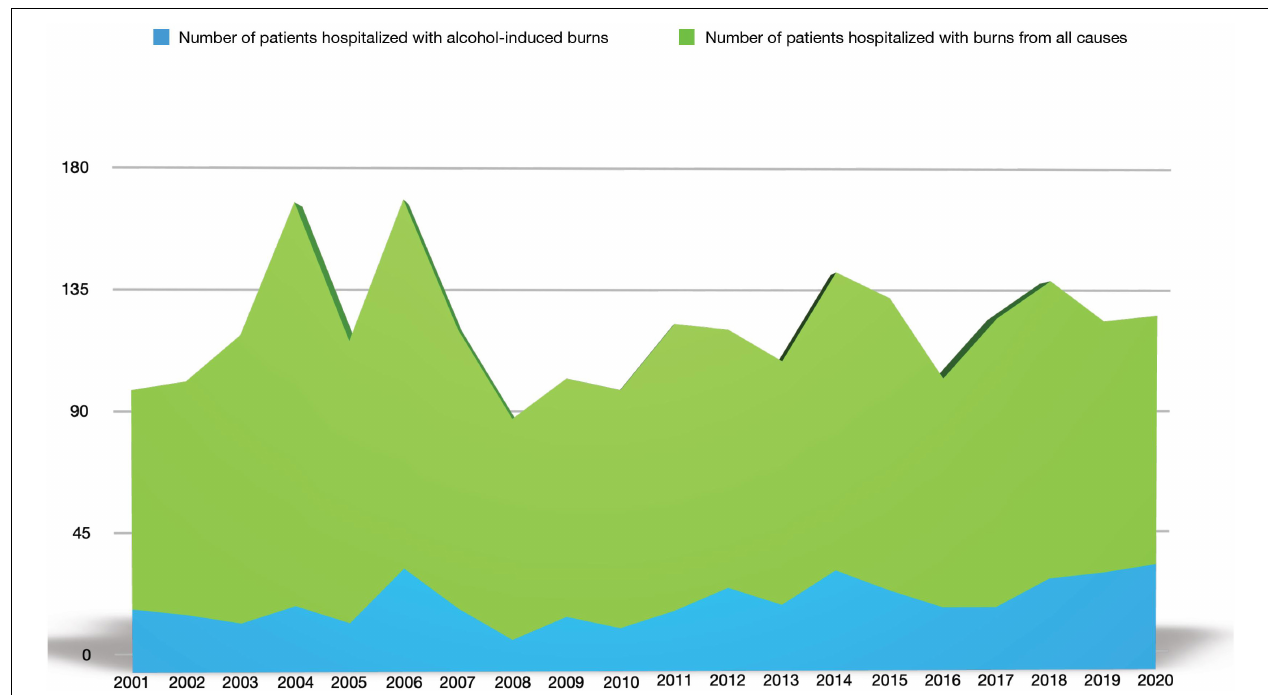
FIGURE 1 | Denatured alcohol-induced burns over all-cause burns in inpatients in our burn center in the period